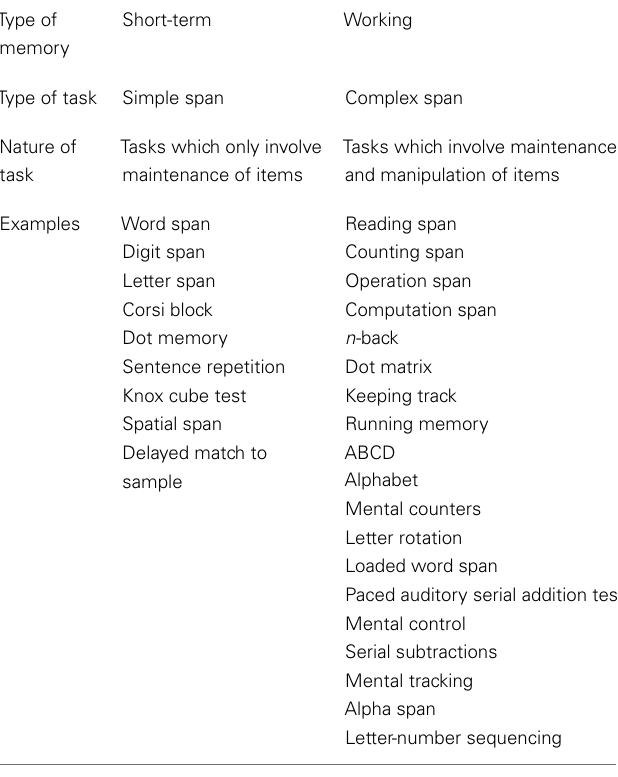
Table 1 | Examples of simple and complex span tasks (not exhaustive).